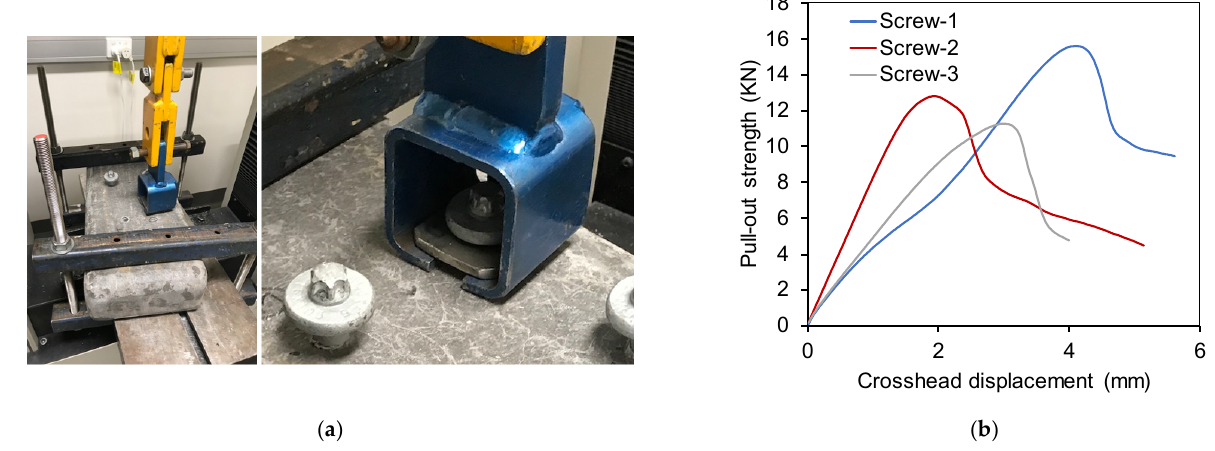
Figure 6. Pull-out behaviour. ( a ) Pull-out test setup. ( b ) Pull-out force vs displacement.